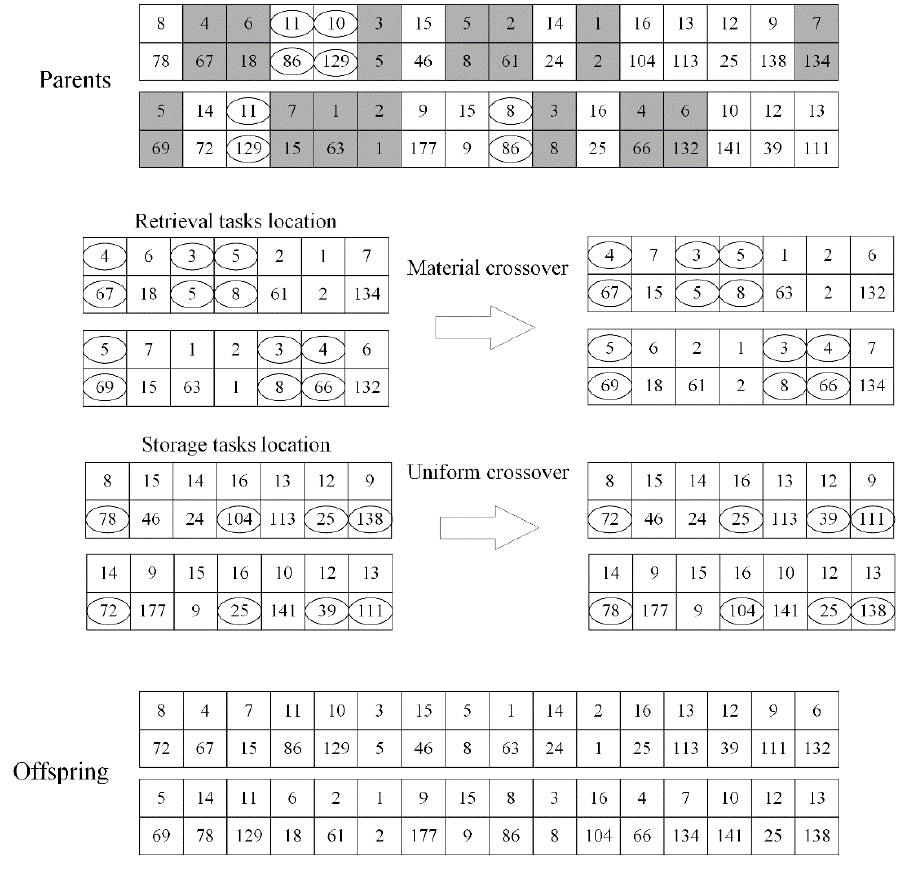
Figure 6. Schematic diagram of the intersection of storage and retrieval tasks.